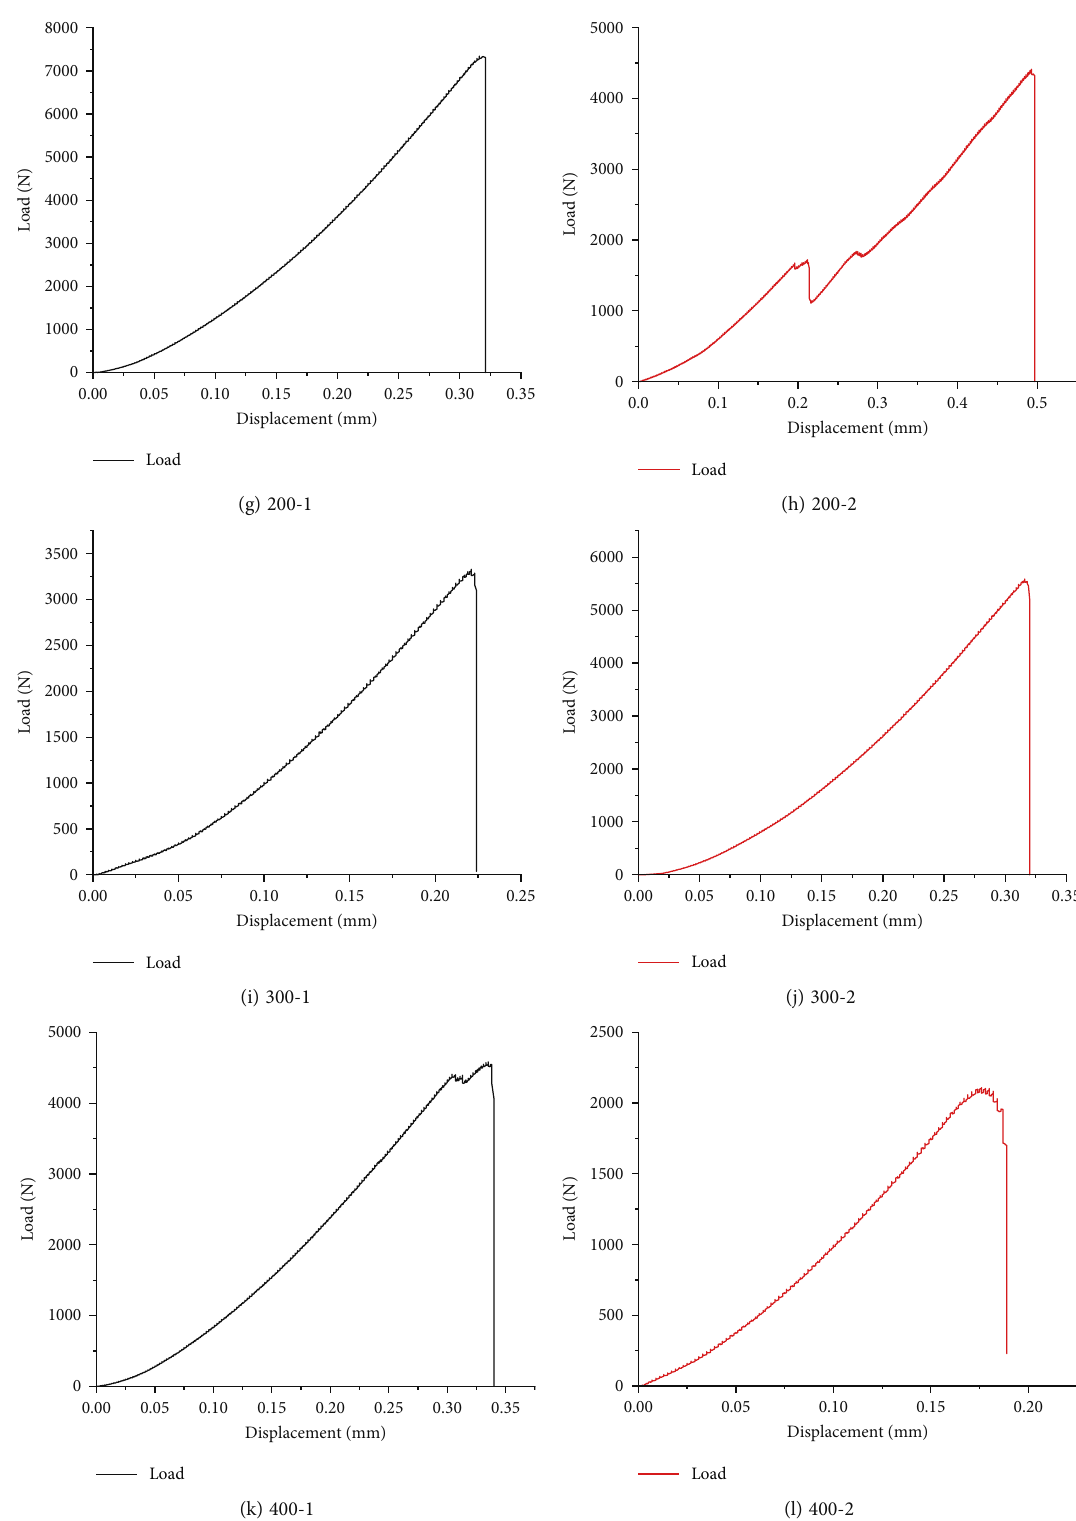
Figure 4: Load displacement curve of rock under di ff erent treatments in three-point bending